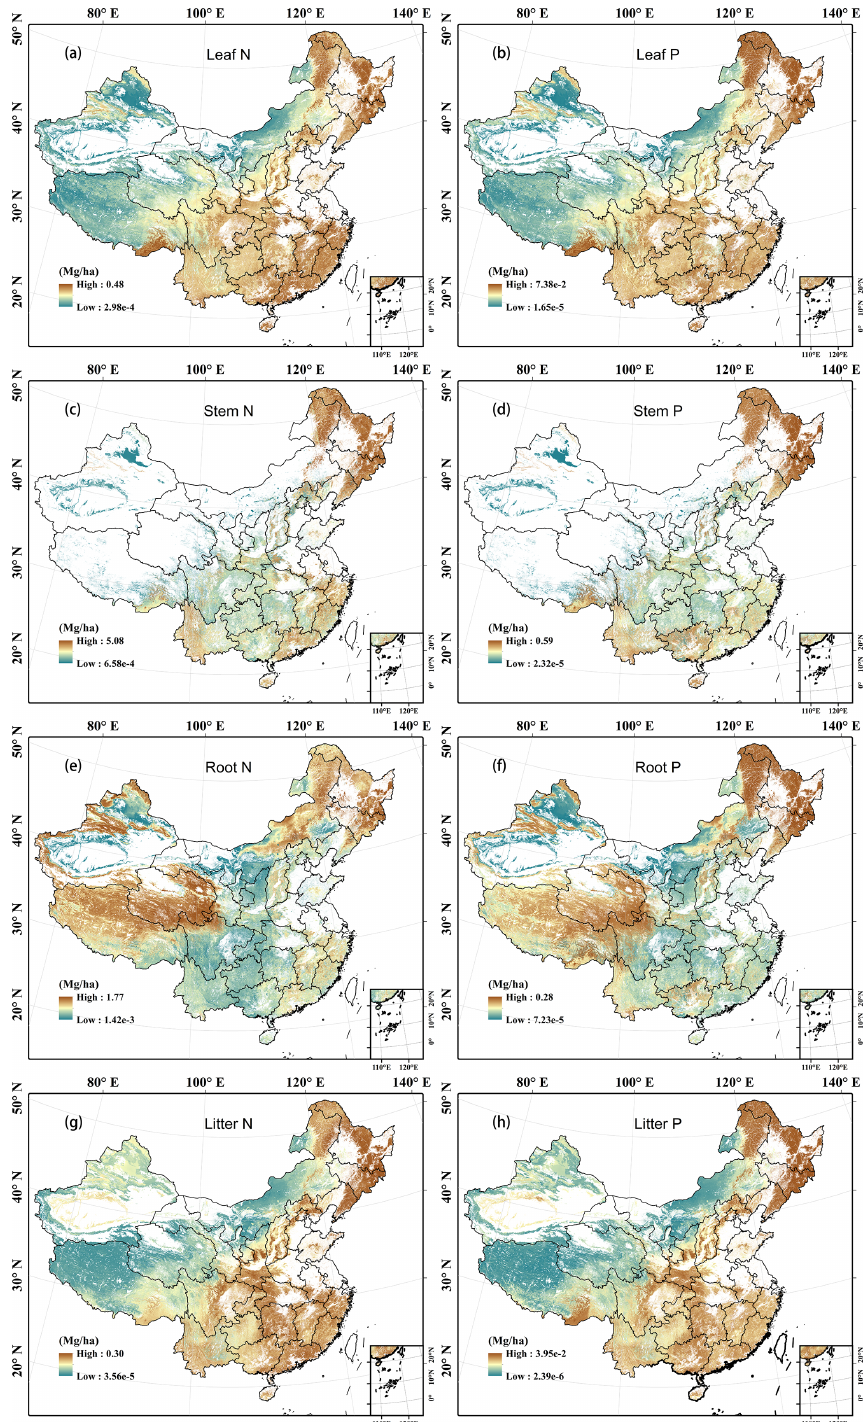
Figure 6. Predicted spatial patterns of N and P densities with a resolution of 1km in leaves (a, b) , woody stems (c, d) , roots (e, f) , and litter (g, h) of terrestrial ecosystems in